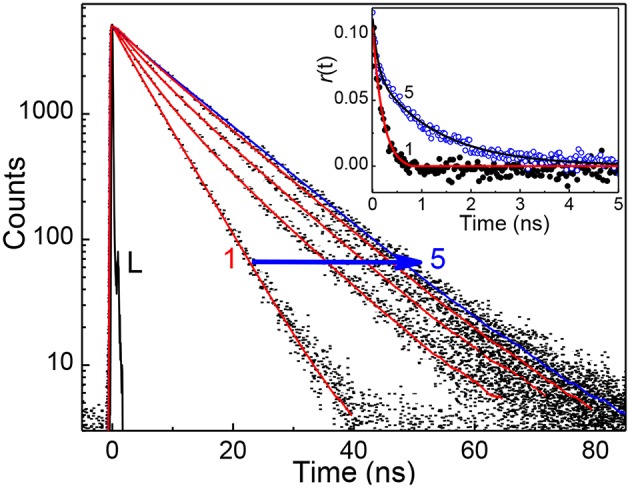
Fluorescence decay traces (λex = 445 nm, λmon = 650 nm) of ~2 μM TMPyP solution at different concentration of captisol. [Captisol]/μM: 0.0 (1), 0.25 (2), 0.5 (3), 1.0 (4), and 22.0 (5). L represents the instrument response function. The inset displays the fluorescence anisotropy traces under the conditions for the fluorescence decay traces 1 and 5.